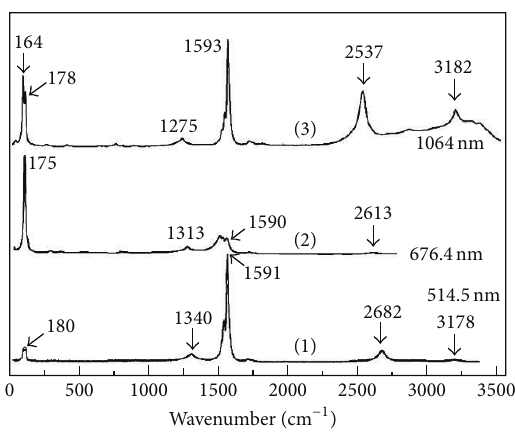
Figure 4: Surface enhanced Raman scattering spectra at different wave excitation lengths: (1) 𝜆 1 = 514.5 nm, (1) (2) 𝜆 2 = 676.4 nm, and (3) 𝜆 3 = 1064 nm of CNTs deposited on gold